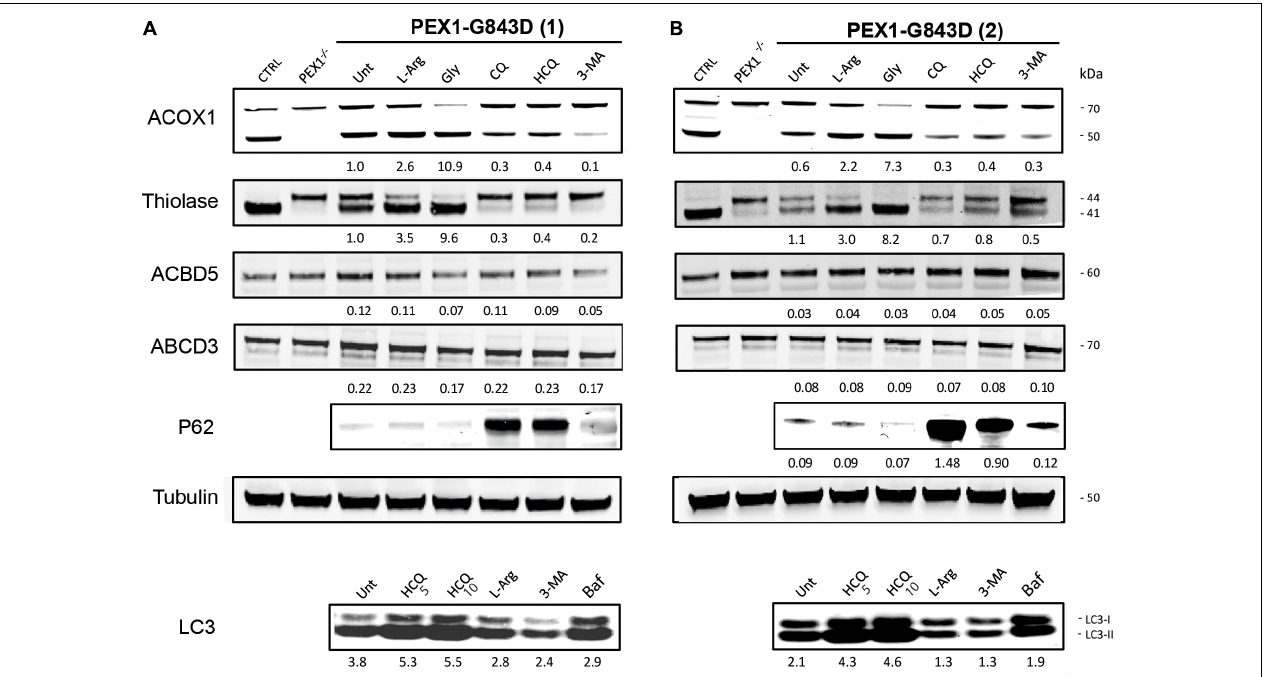
FIGURE 2 | Autophagy inhibitors do not restore peroxisomal import of PTS1- and PTS2-targeted peroxisomal matrix proteins in primary PEX1-G843D fibroblasts. Immunoblot analysis of homogenates of primary fibroblasts from two PBD-ZSD patients homozygous for the PEX1-G843D mutation [PEX1-G843D(1) (A) and PEX1-G843D(2) (B) ] treated as described in Figure 1A . The protein levels of the PMPs ACBD5 and ABCD3 and the ratio of the processed over unprocessed forms of PTS1-targeted ACOX1 and PTS2- targeted thiolase were determined using specific antibodies. Below the ACOX1 bands, the corresponding ratios between the intensity of processed (50 kDa) over unprocessed (70 kDa) ACOX1 bands are indicated. Below the thiolase bands, the corresponding ratios between the intensity of processed (41 kDa) over unprocessed (44 kDa) thiolase bands are indicated. Below the ACBD5 and ABCD3 bands, the corresponding signal intensity relative to the tubulin band intensity, which was used as a loading control, is indicated. Homogenates of non-treated control fibroblasts and PEX1-null fibroblasts (PEX1 − / − ) were used for reference. The effect of the different treatments on autophagy was assessed by determining the relative protein levels of the autophagy adaptor protein SQSTM1/P62 (P62; relative to tubulin levels) and the ratio of MAPILC3B-II (LC3-II) over MAPILC3B-I (LC3-I). Cells were incubated for 7 days with the different compounds, except for bafilomycin (24 h incubation). Experiments were repeated twice; shown are representative blots from one experiment.